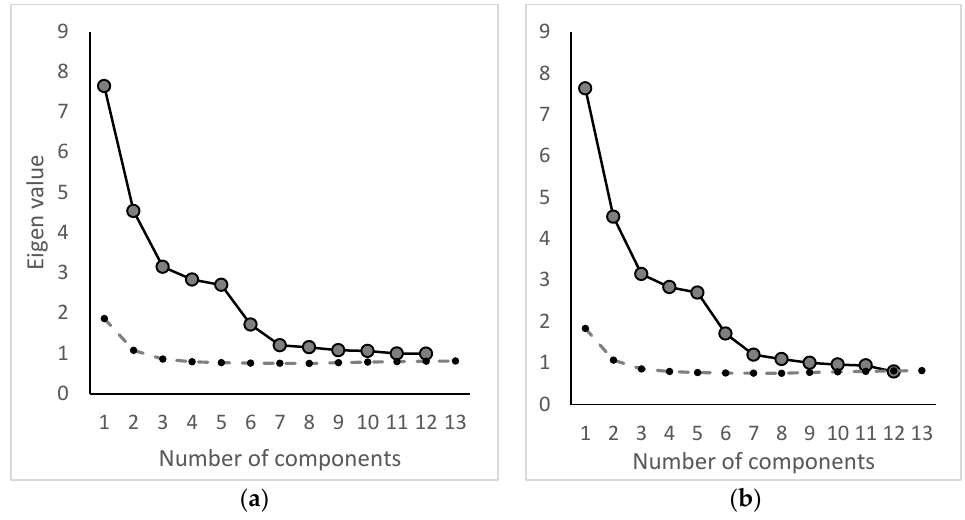
Figure 6. ( a ) Initial scree plot, where seven factor components were retained. ( b ) Final scree plot, where seven factor components were retained. The dotted line represents Horn’s parallel analysis.